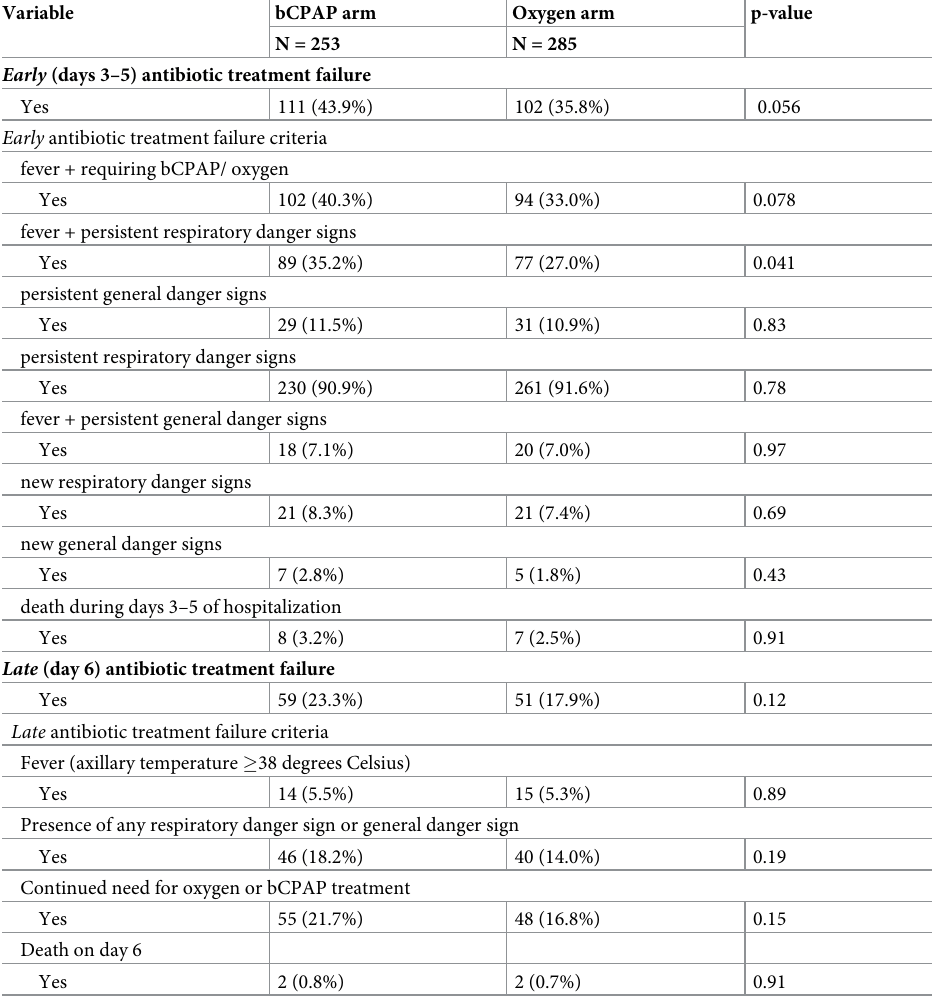
Table 4. Criteria for antibiotic treatment failure by study